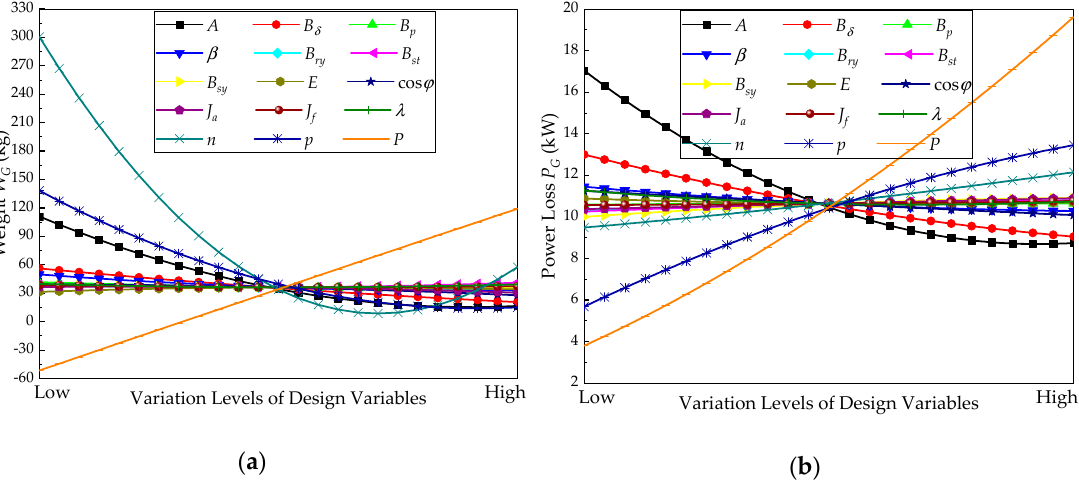
Figure 7. Main effect plots of the generator: (a) main effect plots for the weight; (b) main effect plots for the power loss.